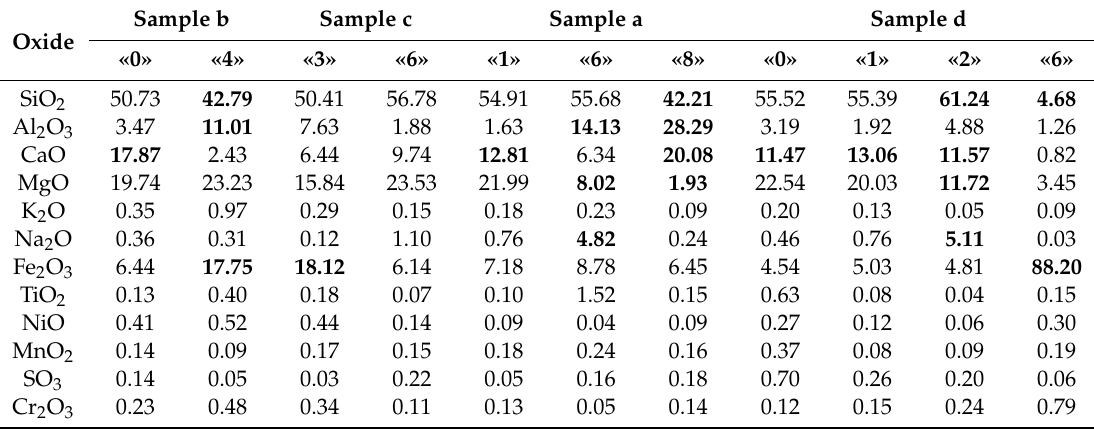
Table 1. Oxide composition measured by SEM-EDS on spots indicated in Figure 1 for samples a to c. Characteristic values in